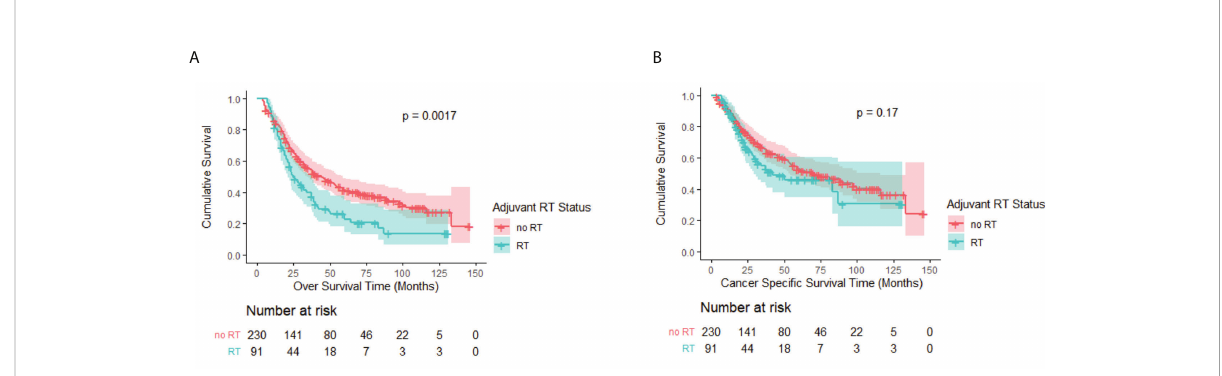
FIGURE 2 (A) Kaplan – Meier OS curve by adjuvant RT status before PSM. A signi fi cant difference was noted (P = 0.002). (B) Kaplan – Meier CSS curve by adjuvant RT status before PSM. No signi fi cant difference was observed (P = 0.17).